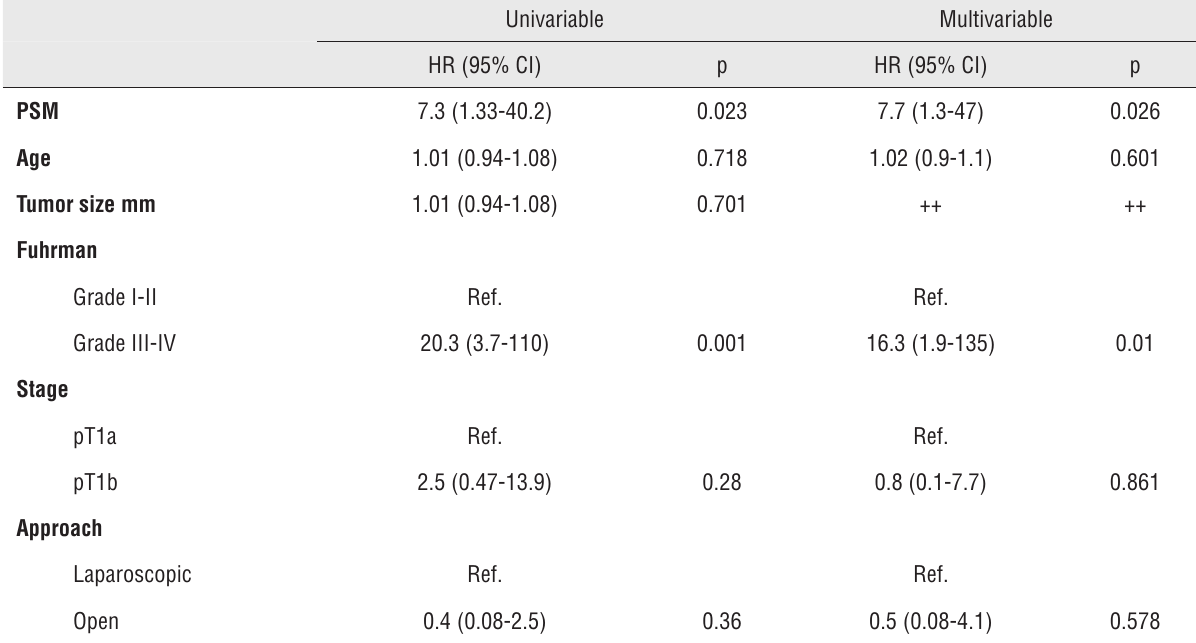
Table 2 - Univariable and multivariable analysis of local recurrence.